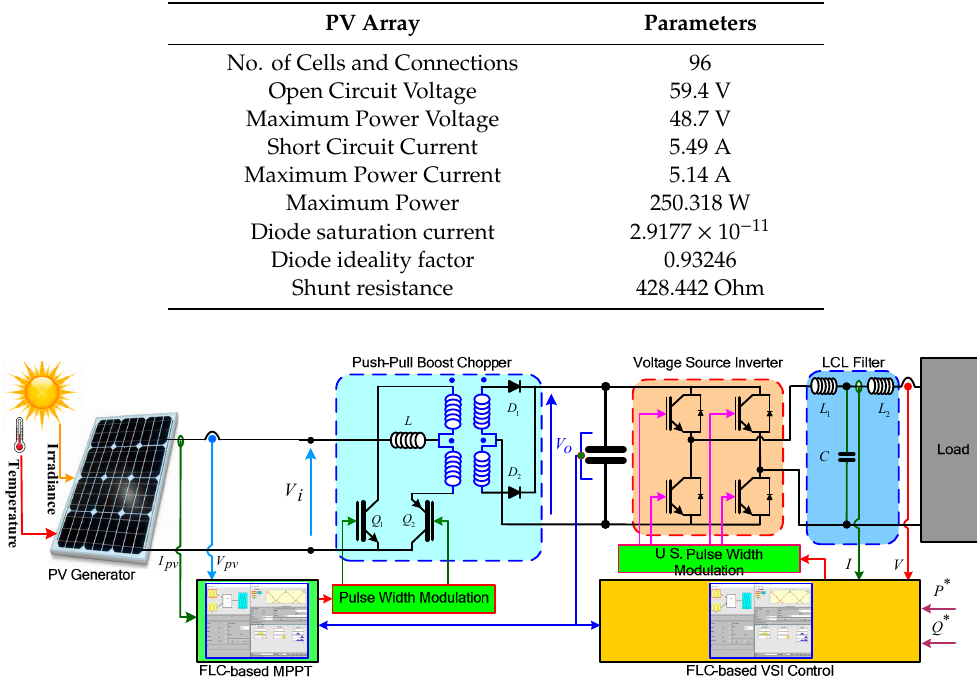
Figure 10. Schematic of the proposed control architecture of the studied system. VSI, voltage source inverter; FLC, fuzzy logic controller.